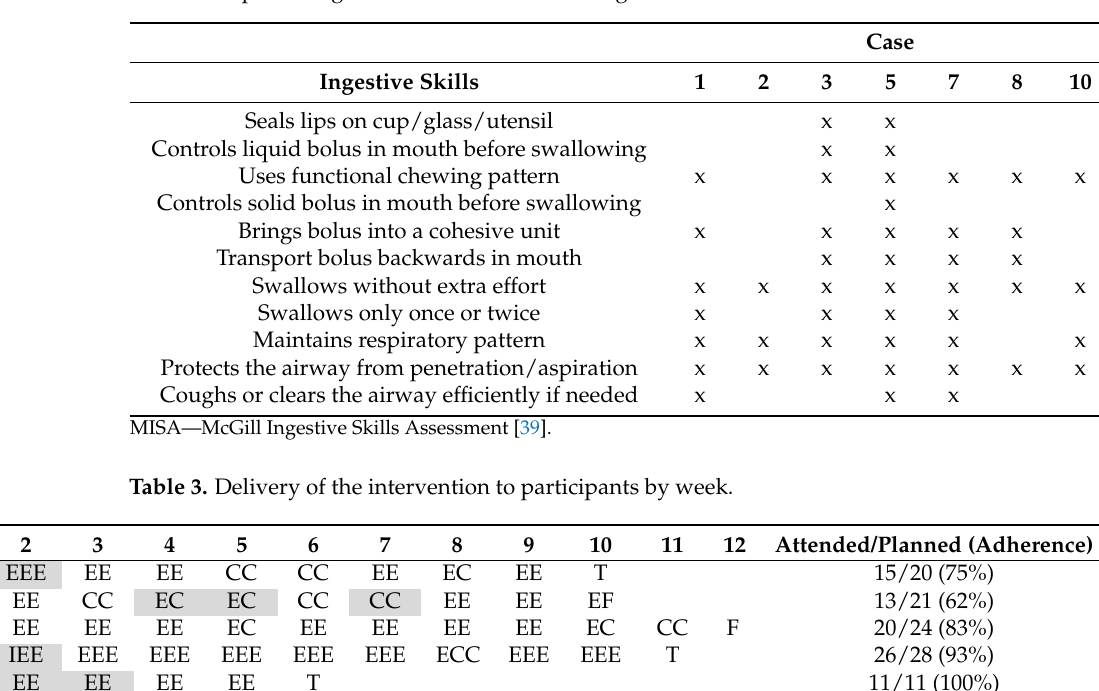
Table 2. Impaired ingestive skills observed during the MISA2 test meal.